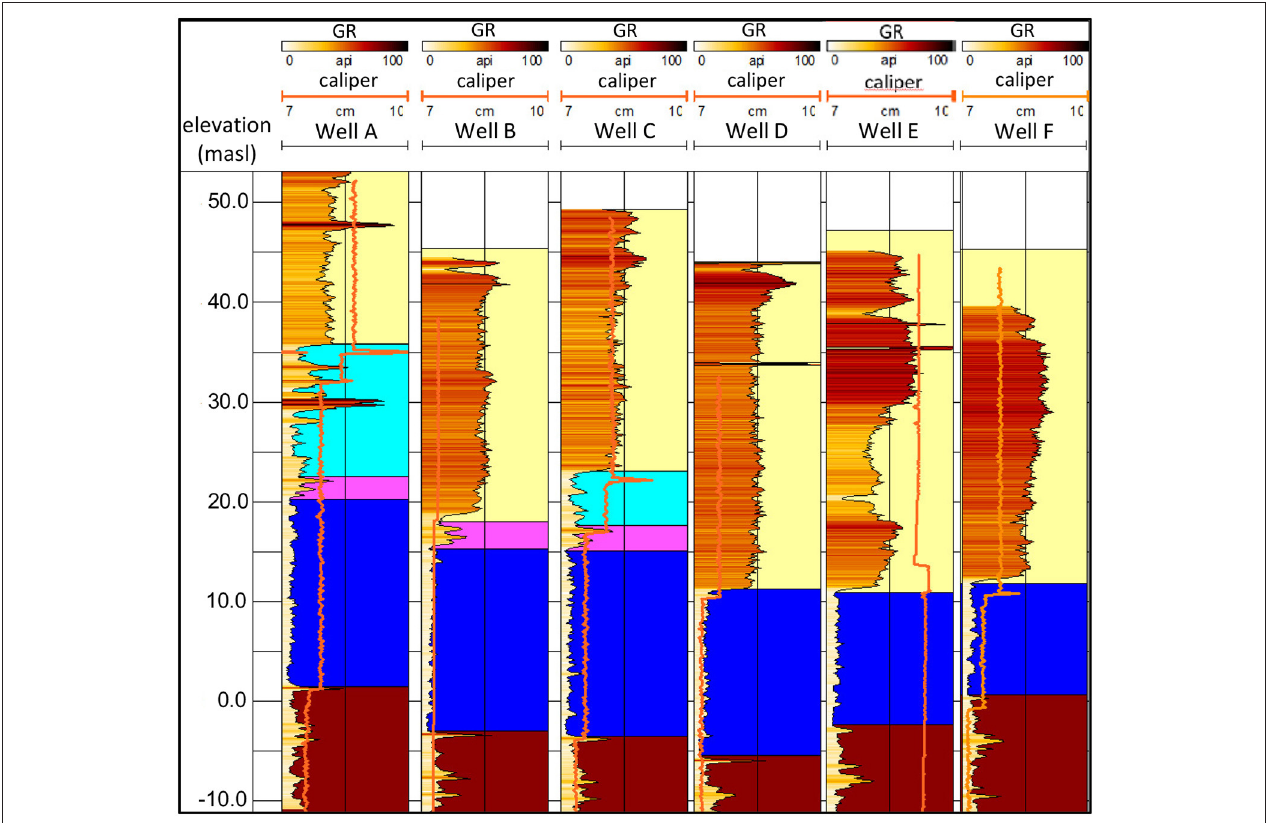
FIGURE 7 | Identification of subunits in the bedrock from gamma ray well logs. Yellow zone is Quaternary sediments; turquoise zone is bedrock subunit 1; pink zone is transitional marker; blue zone is bedrock subunit 2; brown zone is bedrock subunit